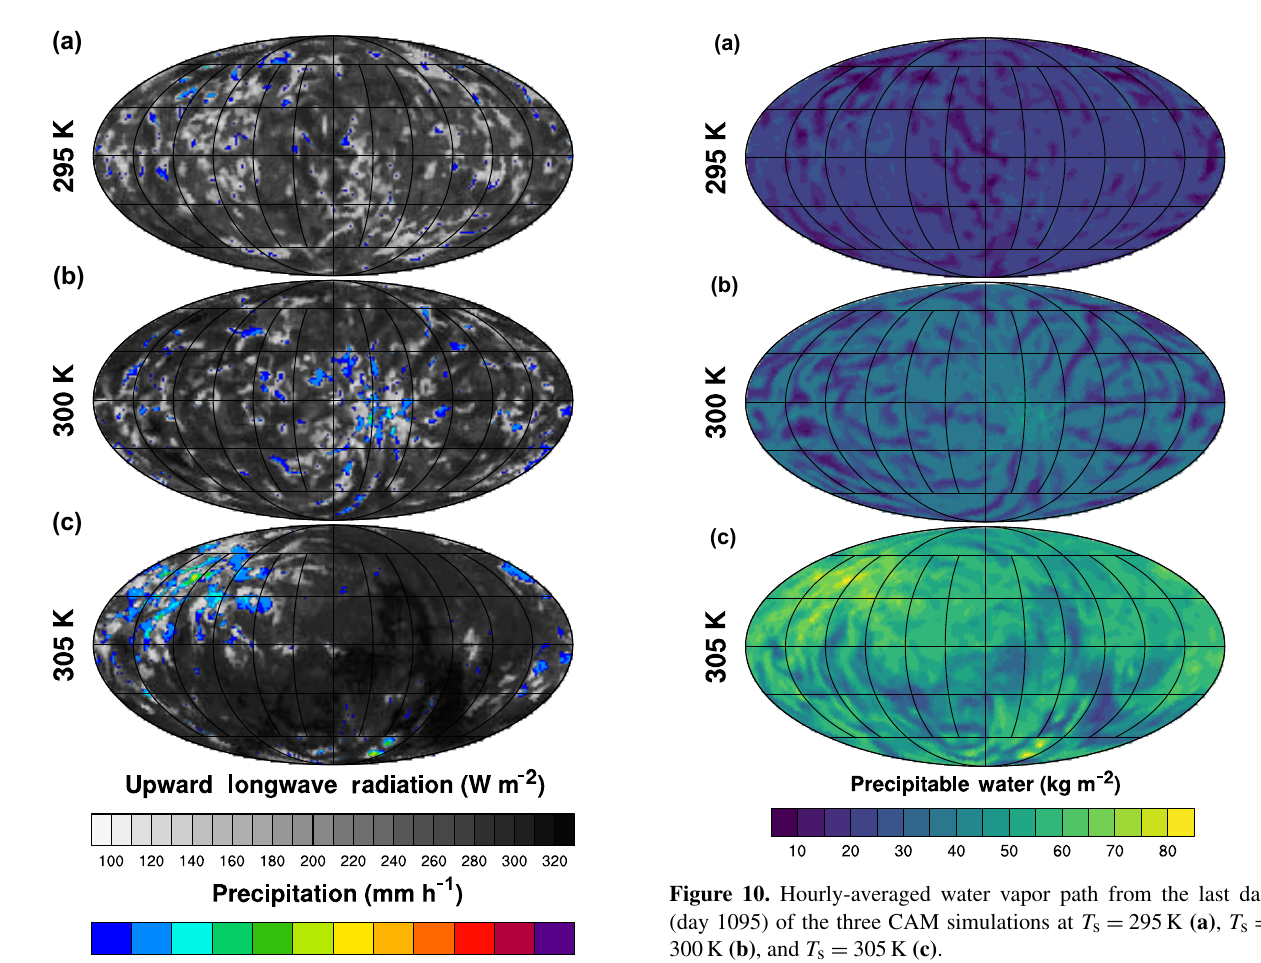
Figure 9. Hourly-averaged snapshot of upward longwave radiation at the top of atmosphere (OLR; gray shading) and precipitation rate (color shading) from the last day (day 1095) of the three CAM sim- ulations at T s = 295K (a) , T s = 300K (b) , and T s = 305K (c) .